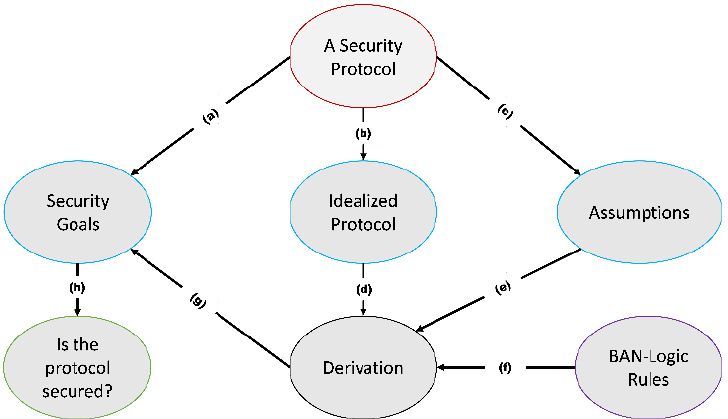
Figure 2. A typical BAN logic formal analysis procedure. ( a ) Security goals are extracted from the protocol’s security requirements. ( b ) The security protocol is put in idealized form. ( c ) Realistic assumptions about the protocol is made. ( d – f ) Derivation uses these inputs to derive the stated goals. ( g ) The security goals are checked if the derivation satisfies them. ( h ) Based on the results of ( g ), the protocol is validated as safe or not. Table 1. BAN logic notations. Table 2. BAN logic